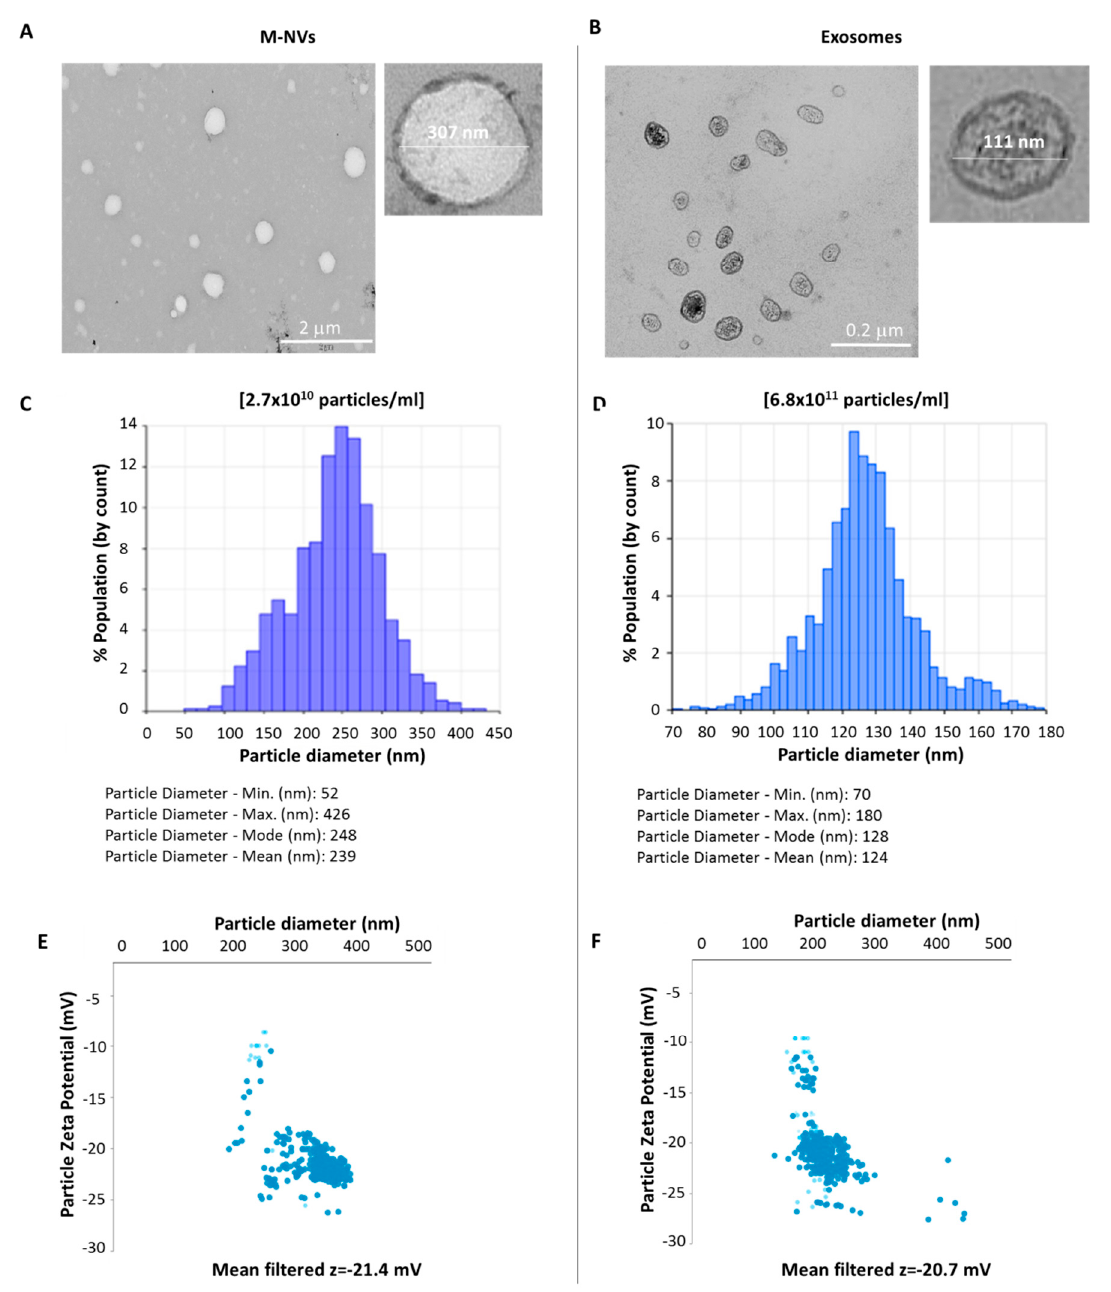
Figure 2. TEM ultrastructural analysis ( A , B ), size and concentration ( C , D ) and z-charge ( E , F ) Figure2. TEMultrastructuralanalysis( A , B ),sizeandconcentration( C , D )andz-charge( E , F )comparison comparison between membranes reassembling mimetic nanovesicles (M-NVs) and exosomes both between membranes reassembling mimetic nanovesicles (M-NVs) and exosomes both isolated form isolated form T98G cells, determined through TRPS analysis (qNano Gold, Izon). T98G cells, determined through TRPS analysis (qNano Gold,